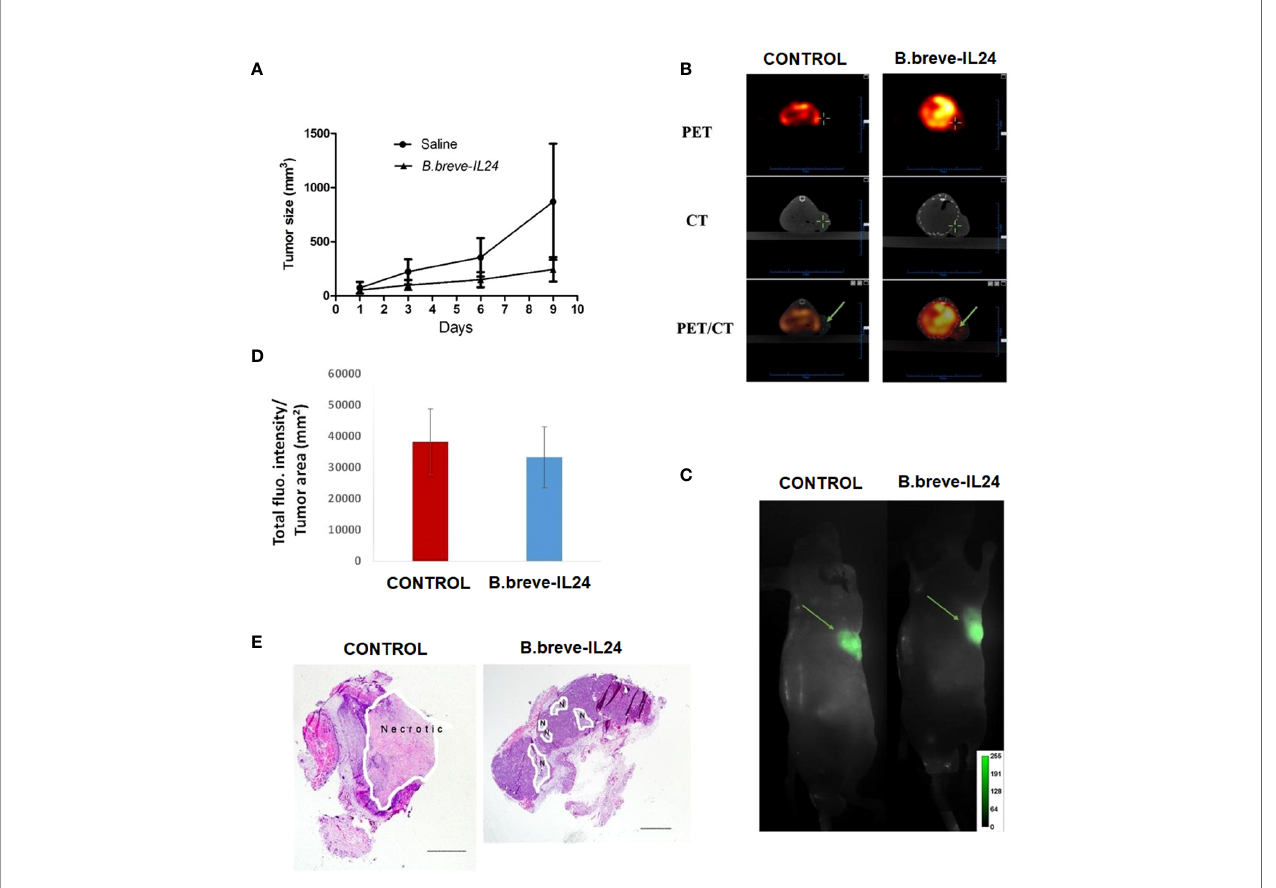
FIGURE 5 | Growth curve, apoptosis induction, and necrotic tissue detection in mice bearing a WSU-HN6 tumor treated with (B) breve-IL24 in vivo . (A) Tumor growth curve over 2 weeks of therapy. (B) Tumor uptake of 18 F-ML-10 tracer in vivo by PET/CT scanning; the detected radioactivity was 135.35 m Ci for the treatment group (volume 169.13 mm³) and 20.09 for the control group (volume 129.96 mm³). (C) Real-time FRI images of the tumor necrotic area (ICG fl uorescence) (D) quanti fi cation of total tumor fl uorescence within the tumor in treatment and control group, p<0.045 (E) H&E staining of tumor tissues, scale